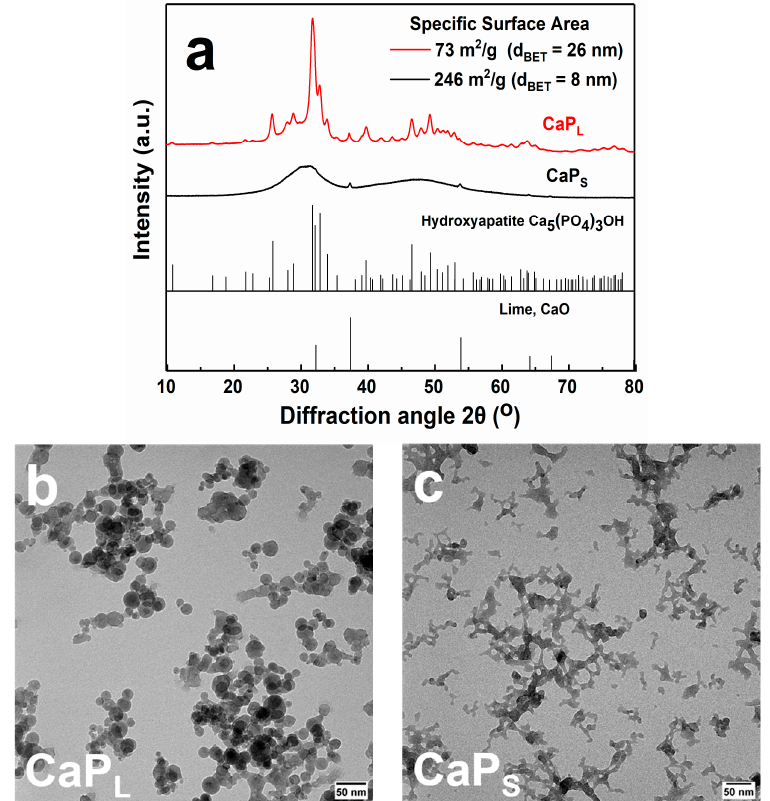
Figure 1. ( a ) X-ray diffraction (XRD) patterns of the CaP nanoparticles. The specific surface area (SSA), as determined by the nitrogen adsorption–desorption isotherms, along with the corresponding primary particle size, d BET , are also shown. By varying FSP synthesis conditions either crystalline or amorphous particles are obtained. Main peaks are assigned to hydroxyapatite, Ca 5 (PO 4 ) 3 OH, whereas CaO is also observed. Transmission electron microscopy (TEM) images of as-prepared CaP L ( b ) and CaP S ( c ) samples. CaP L particles are spherical with loosely agglomerated structure, while fused particles with sintered necks are clearly illustrated for CaP S (Scale bar 50 nm).